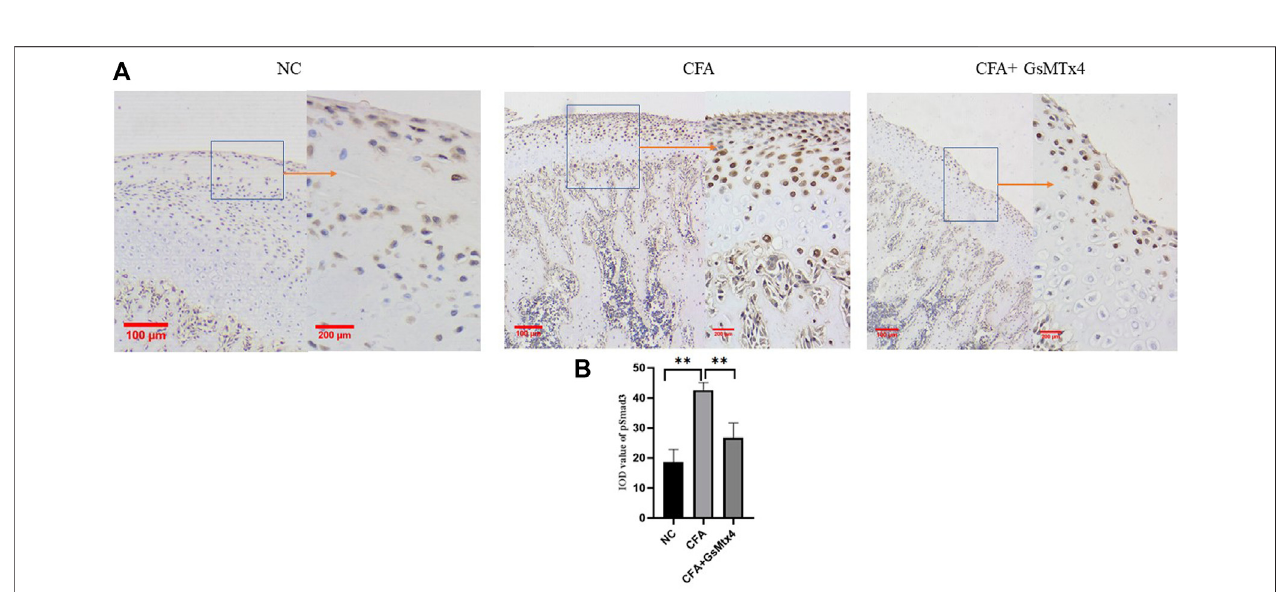
FIGURE 6 | (A) pSmad3 expression in each group; (B) Statistical analysis of the pSmad3 expression in each group. ** p <